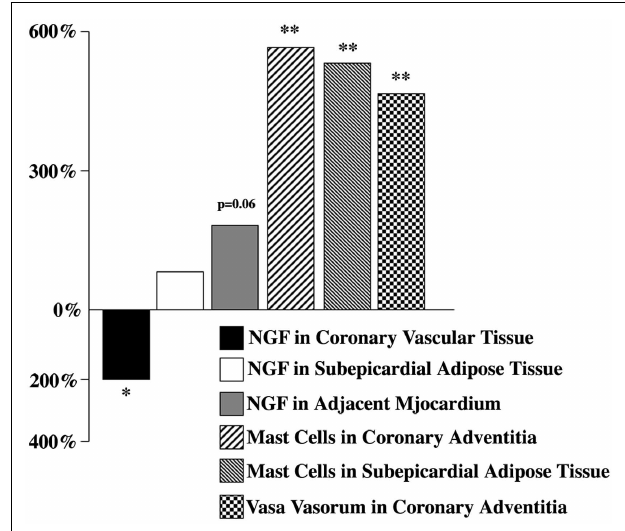
FIGURE 2 | Nerve growth factor, mast cell, and vasa vasorum changes in selected human atherosclerotic cardiac tissues expressed as percentage of controls . Modified from Ref. (34).